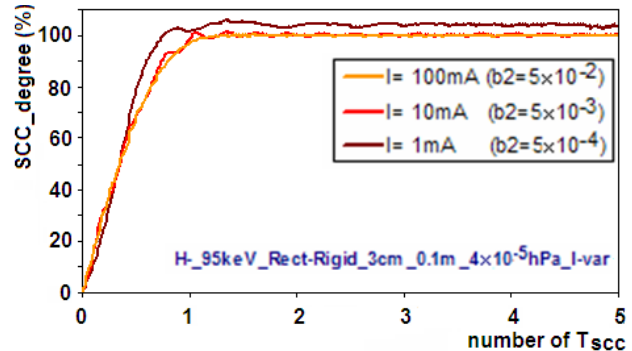
FIG. 11. (Color) H (cid:2) beam SCCD for various